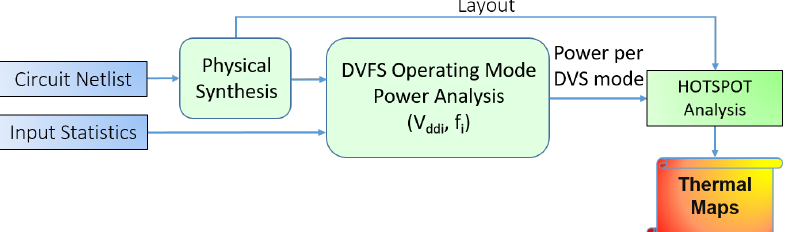
Figure 3. Flow for obtaining thermal maps after physical